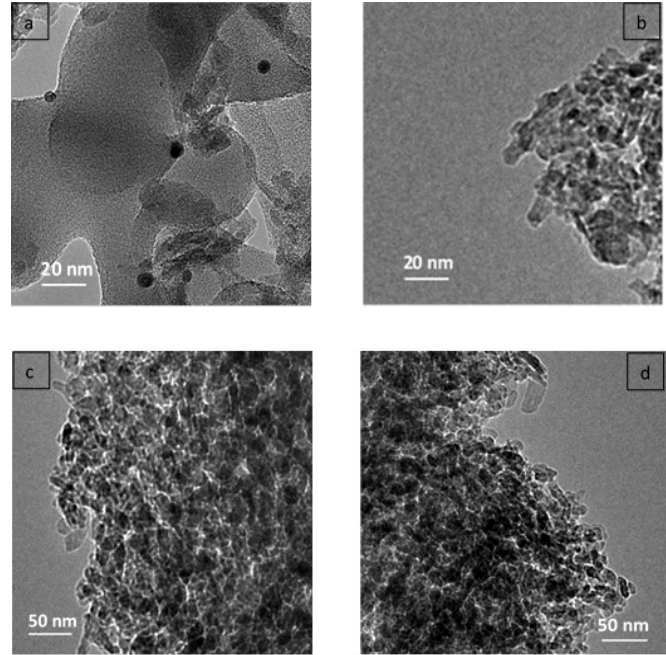
Figure 2. TEM images of ( a ) 1% Pt–Al 2 O 3 , ( b ) 1% Cu–Al 2 O 3 , ( c ) 20% Cu–Al 2 O 3 (4 h), and ( d ) 20% Cu–Al 2 O 3 (8 h).